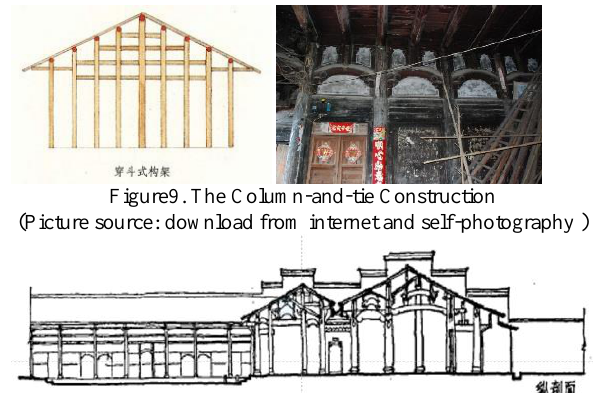
Figure6. Fung Shui principle on the site selection (Picture source: self-drawing)